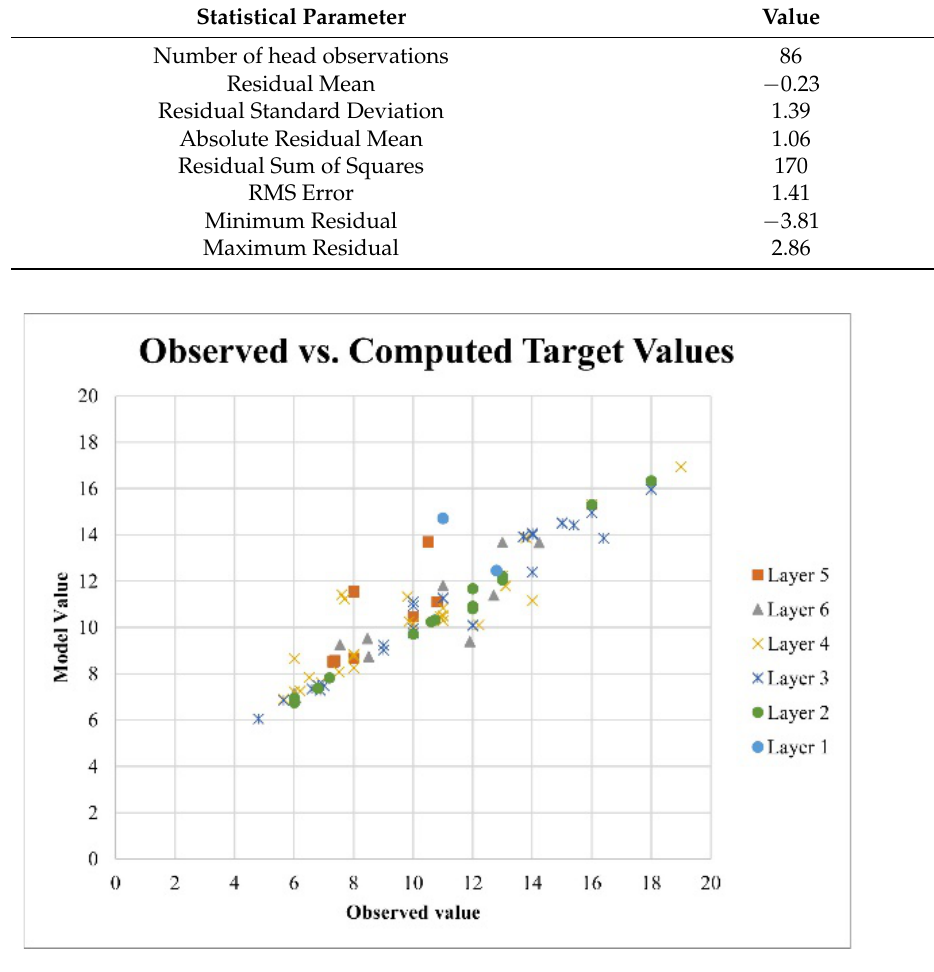
Figure 11. Scatterplot of observed versus computed target values. The process of calibration produced an estimate of the optimum value of hydraulic conductivity in correspondence with the model targets; the estimated values of k were then interpolated, for each layer, by the software using Ordinary Kriging (Figure 12). In addition to the values of k, recharging was also calculated, arriving an optimum value of 0.00068